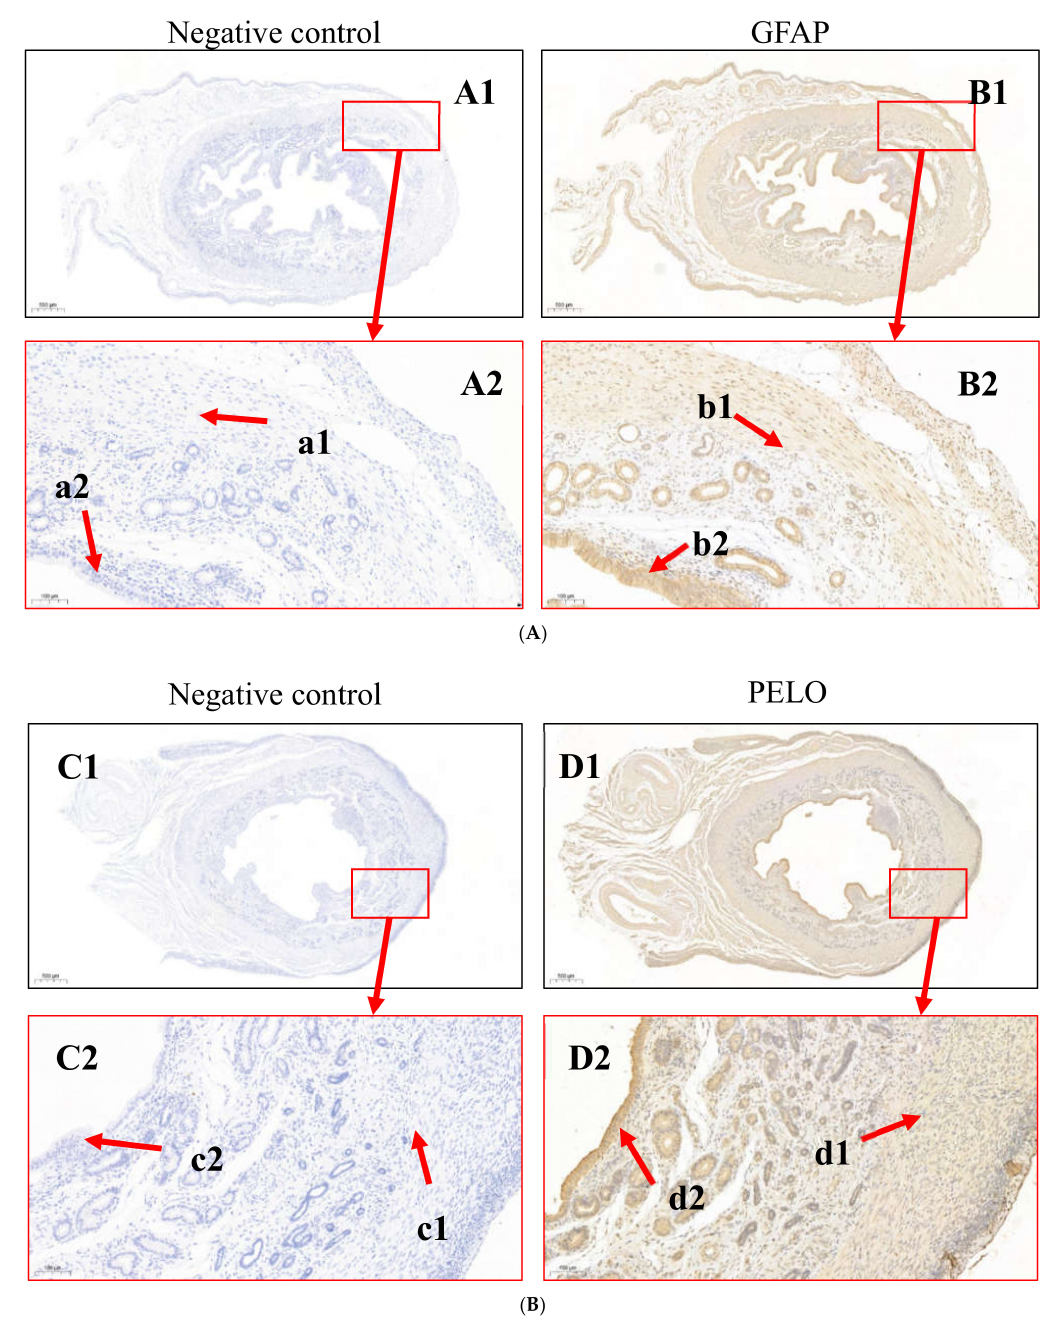
Figure 6. ( A ) Analysis of GFAP localization in the uterine tissue of Qianbei-pockmarked goats. a1 and b1 are uterine stromal cells. a2 and b2 are endometrial cells. ( B ) Analysis of PELO localization in the uterine tissue of Qianbei-pockmarked goats. c1 and d1 are uterine stromal cells. c2 and d2 are endometrial